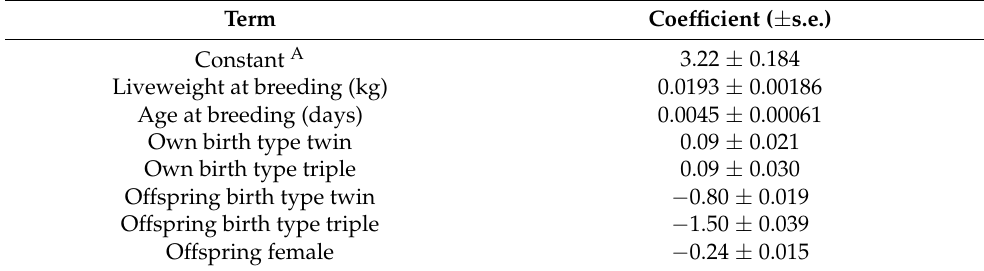
Table 5. Regression coefficients ( ± s.e.) of Restricted Maximum Likelihood Model analysis that predicts birthweight (kg) of individual offspring from liveweight and age of maternal composite ewe lambs at breeding, birth type of ewe lamb and birth type and sex of offspring. Data represents a combined analysis across all years and all terms are significant ( p < 0.001).